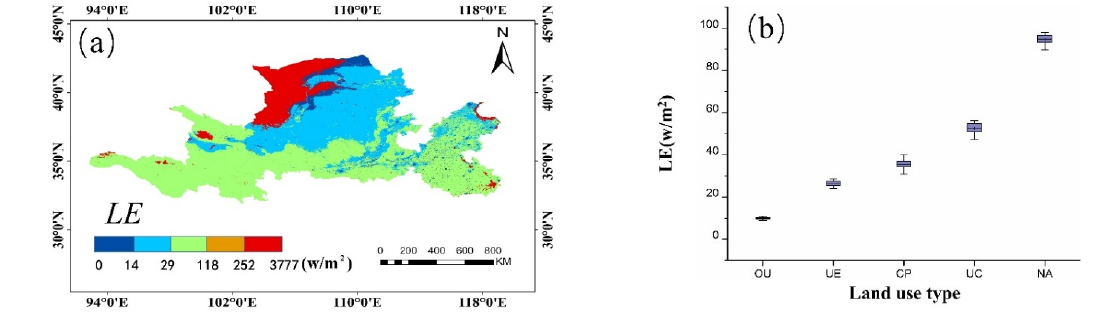
Figure 9. ( a ) Spatial variation of latent heat flux (LE) and ( b ) statistical values for the five land use types in the influence area of the YRB from 2000 to 2015.